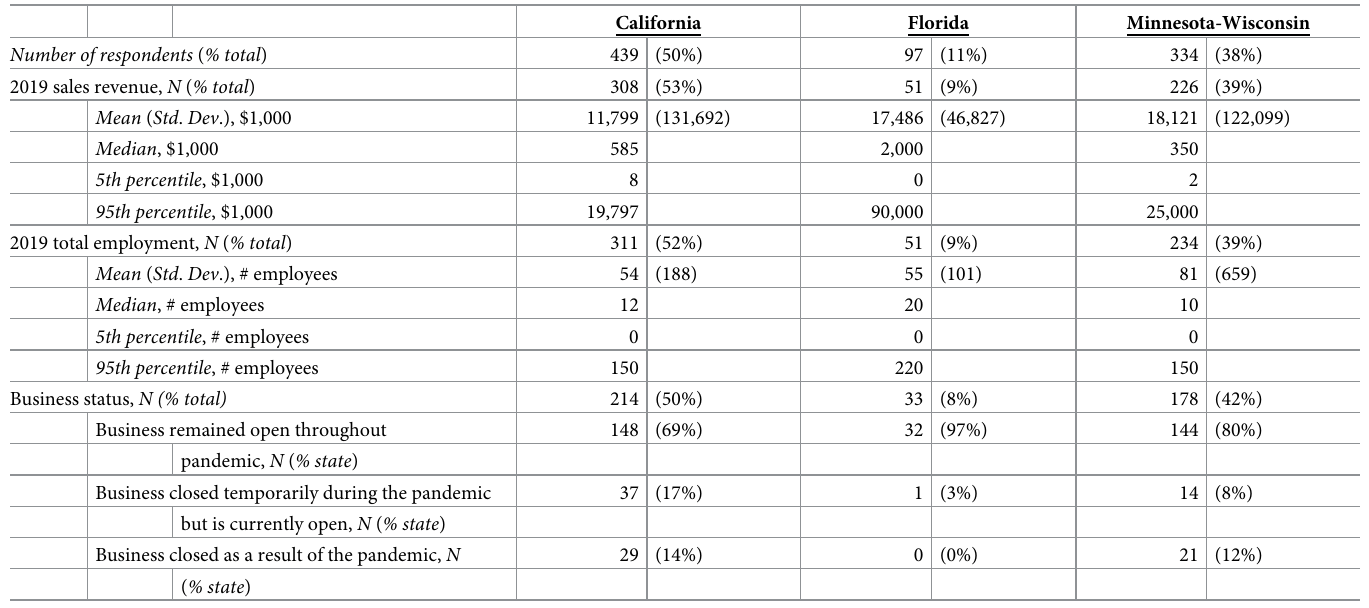
Table 2. Descriptive summary of survey respondents, by study